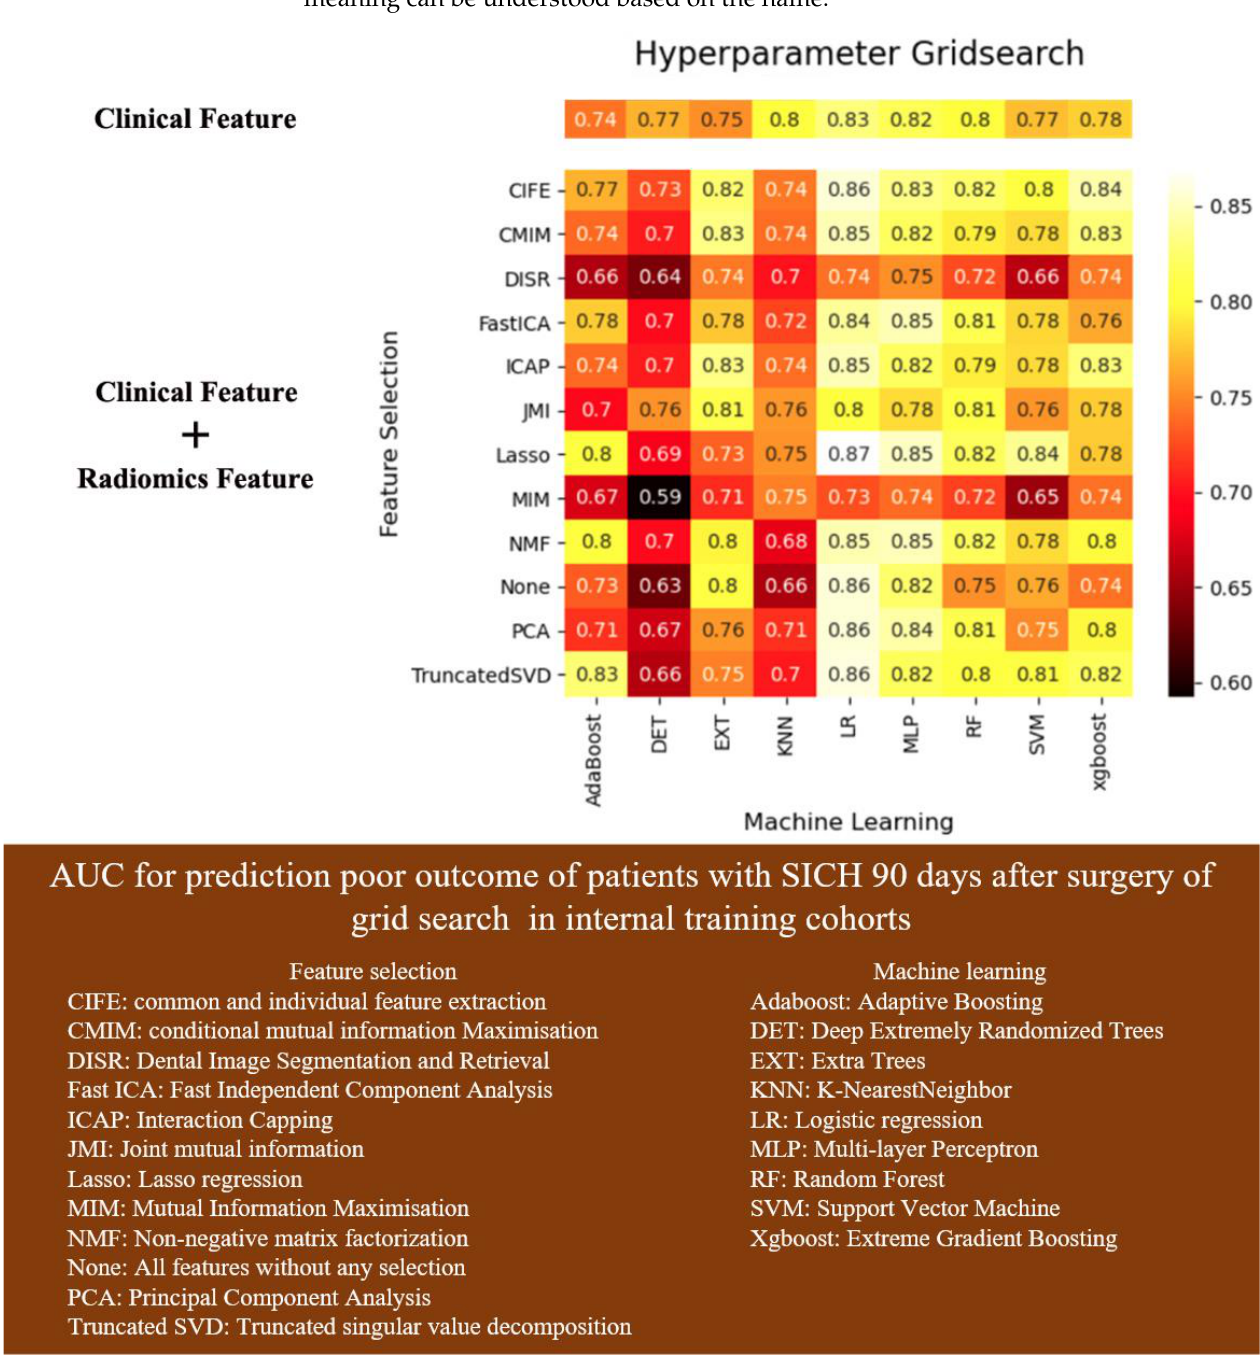
Figure 2. AUC for prediction poor outcome of patients with sICH 90 days after surgery of grid search in internal training cohorts.